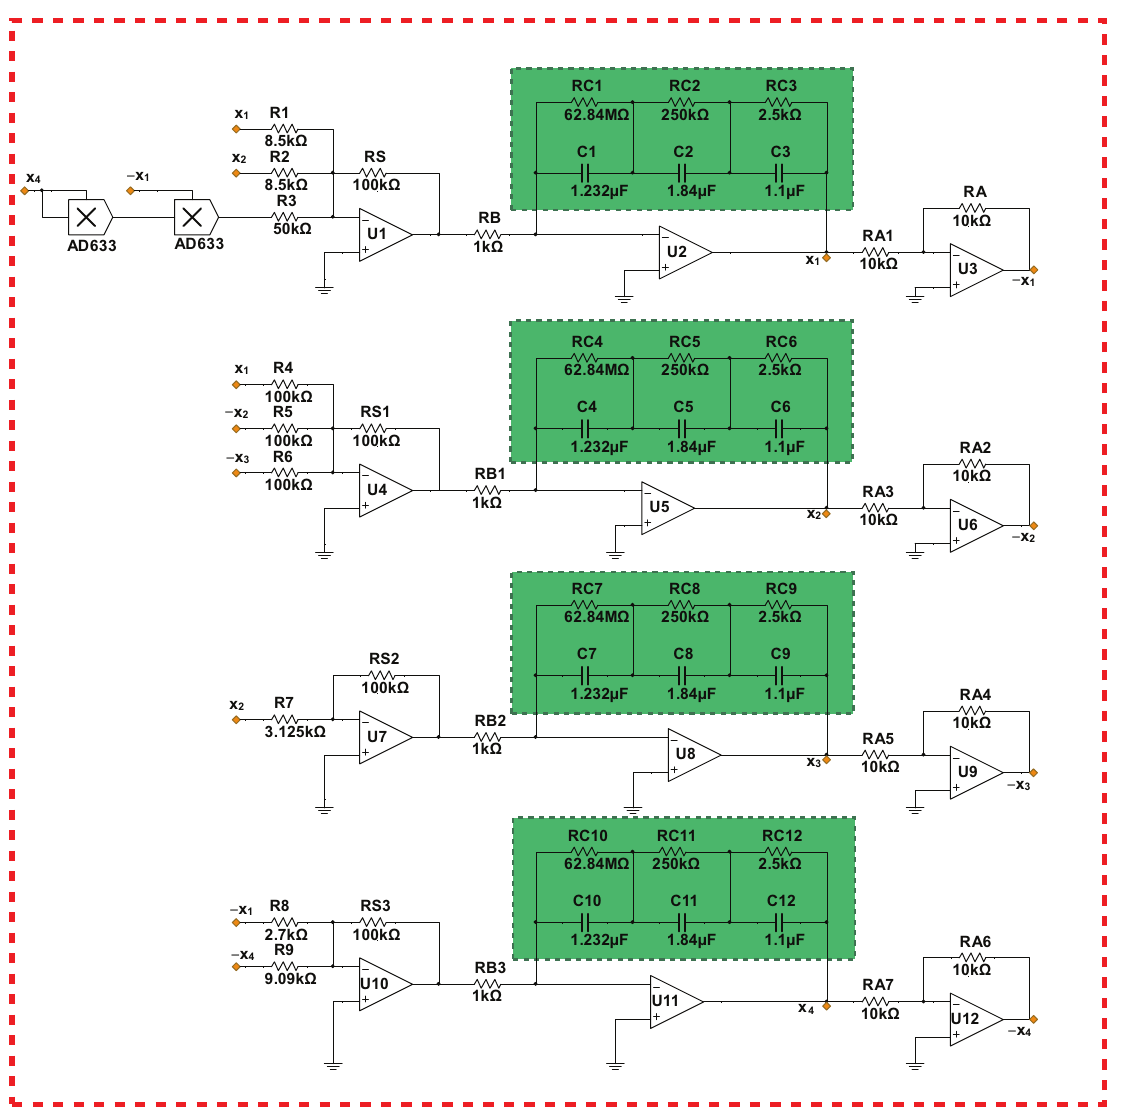
Figure 15. Circuit diagram of fractional-order memristor system (15).